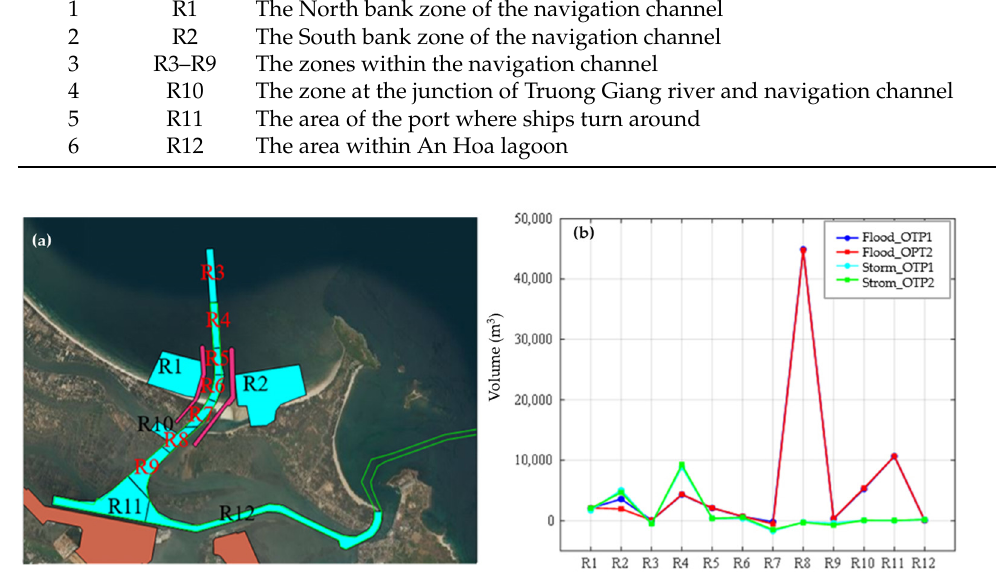
Table 3. Zoning of the areas for sedimentation and erosion analysis. Figure 25. Maximum velocity during the Northeast monsoon ( upper panel) and flood event ( lower panel).